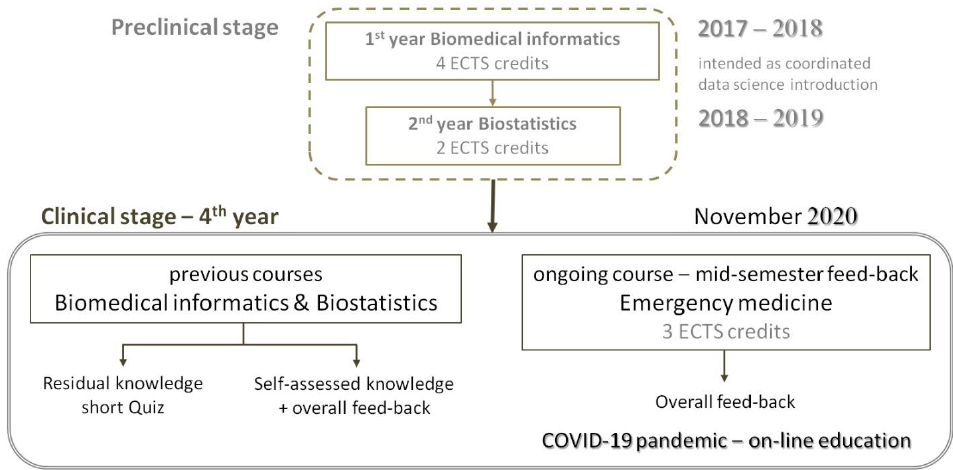
Figure 1. Study flow diagram.